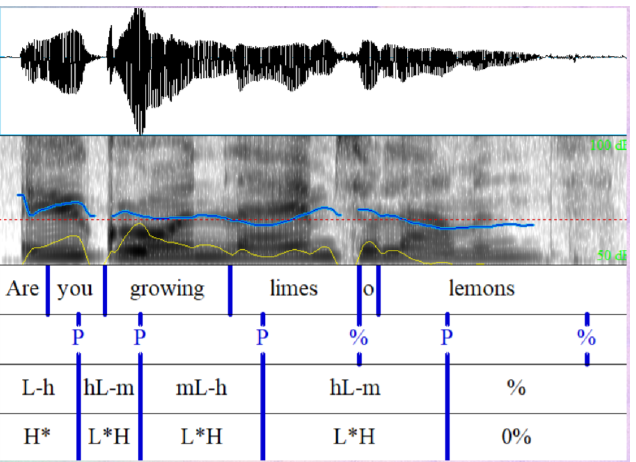
Figure 6. Praat window with multi-layer IViE labelling of the utterance [Are you growing limes][or